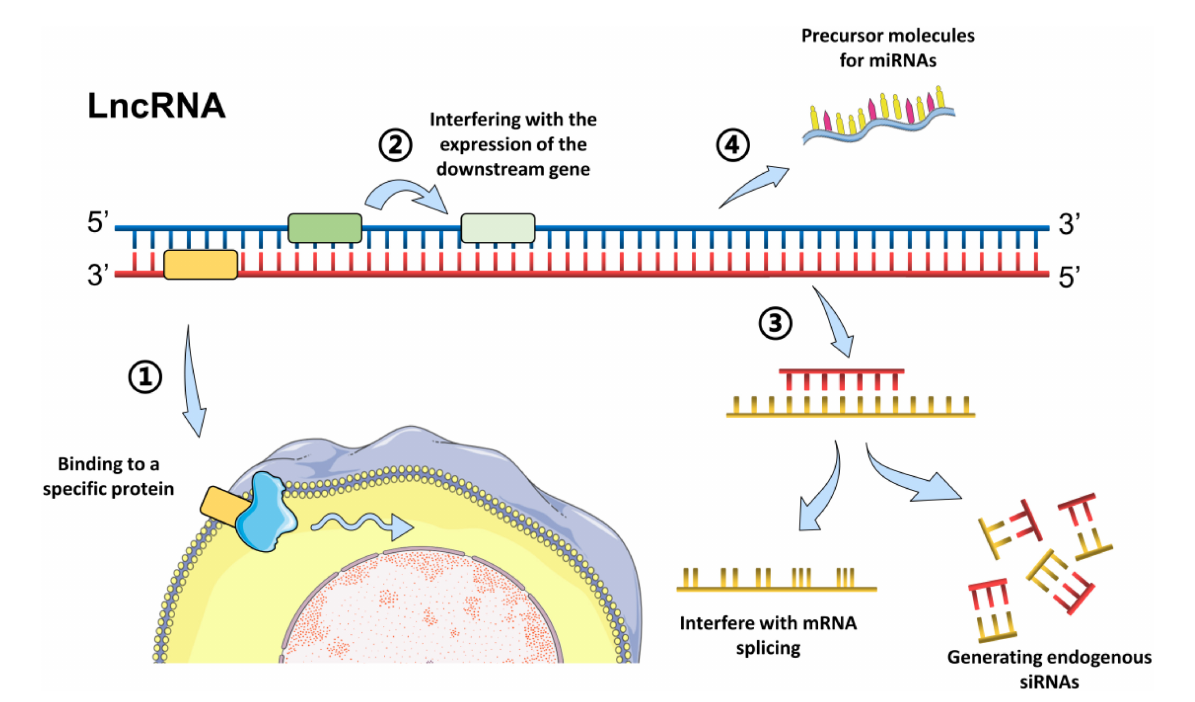
FIGURE1 Common models of action of LncRNAs. Long non-coding RNAs can act through different biological mechanisms, mainly via methods as followings: (1) Bind to a specific protein and regulate its activity directly or indirectly by change the cellular localization via forming nucleic acid-protein complexes; (2) Encode the transcriptional process of the upstream promoter region of a protein gene, inhibit RNA polymerase II or mediate chromatin remodeling and histone modification, or interfere with the expression of the downstream gene. (3) Form complementary double strands with the transcription of the protein-encoding gene and generate endogenous siRNAs under the action of dicer enzyme, or interfere with mRNA splicing, and form different cleavage. (4) Serve as the precursor molecules for miRNAs (Grelet et al., 2017; Ali and